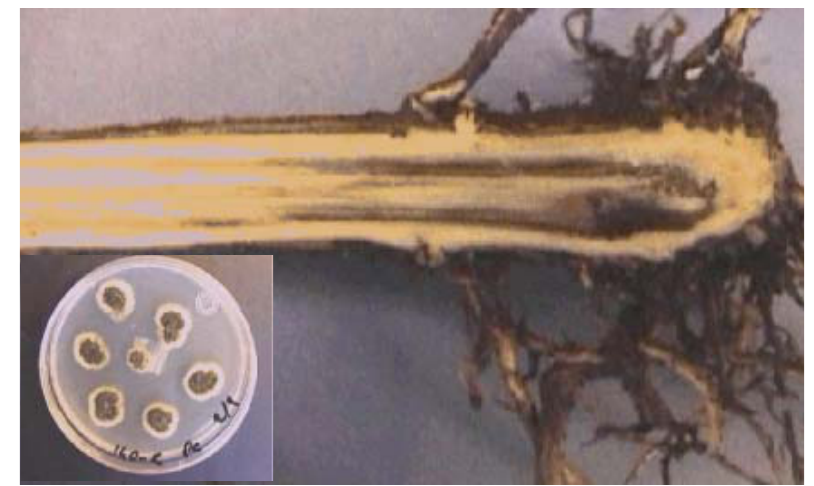
rootstock.Fig. 1. Black streaking in vascular tissue of an inoculated rootstock, and re-isolation of Phaeomoniella chlamy-